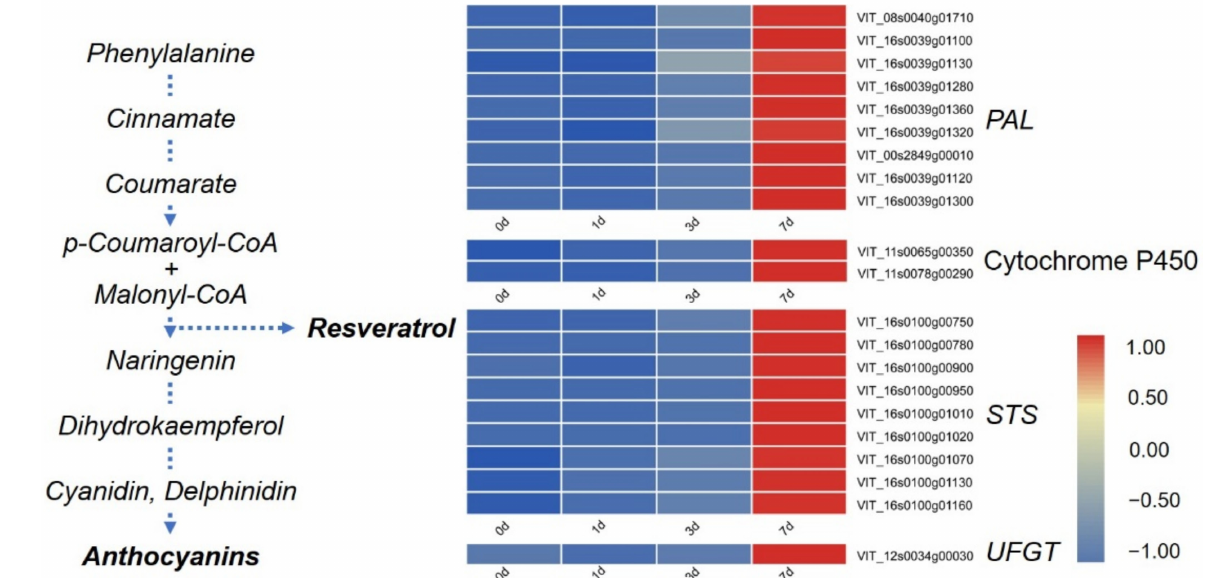
Figure 6. Differentially expressed genes in phenylalanine metabolism pathway that promote stilbene and anthocyanin accumulation in Vitis davidii Föex berries incubated with Colletotrichum viniferum . PAL, phenylalanine ammonia-lyase; STS, stilbene synthase; UFGT, UDP-glucose: flavonoid 3-O- glucosyltransferase. Heat maps of genes were constructed with transcriptome quantitative data. The genes that increased and decreased are displayed in red and blue,